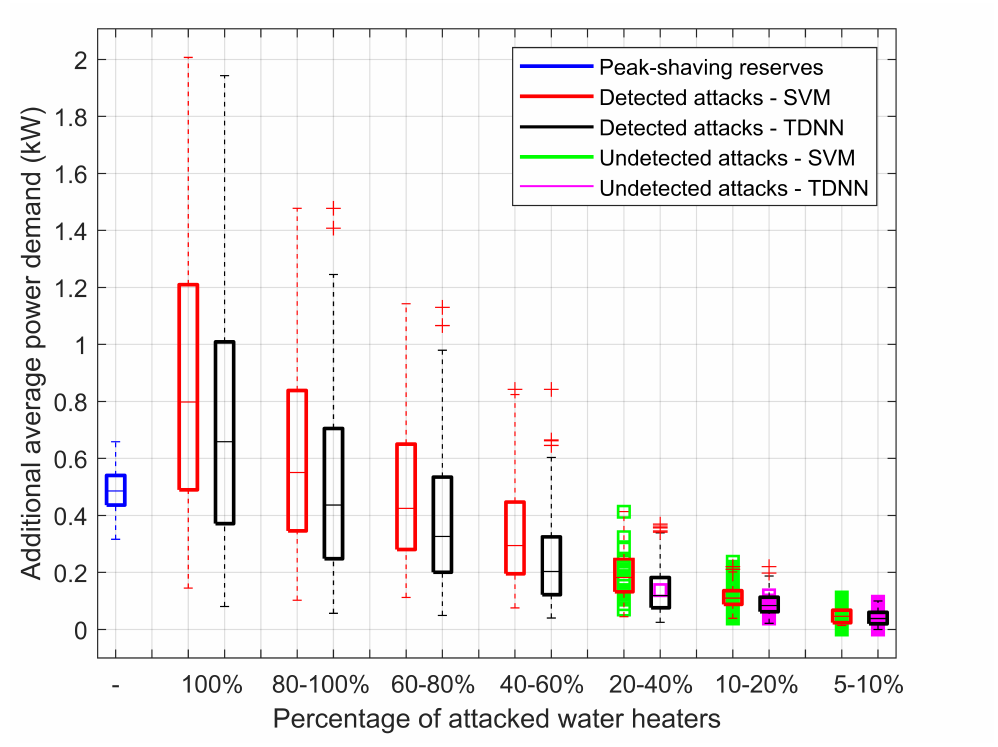
Figure 5. Excess power demand generated by DLC attacks activating a subset of EWHs in the absence of mitigation—winter mornings.